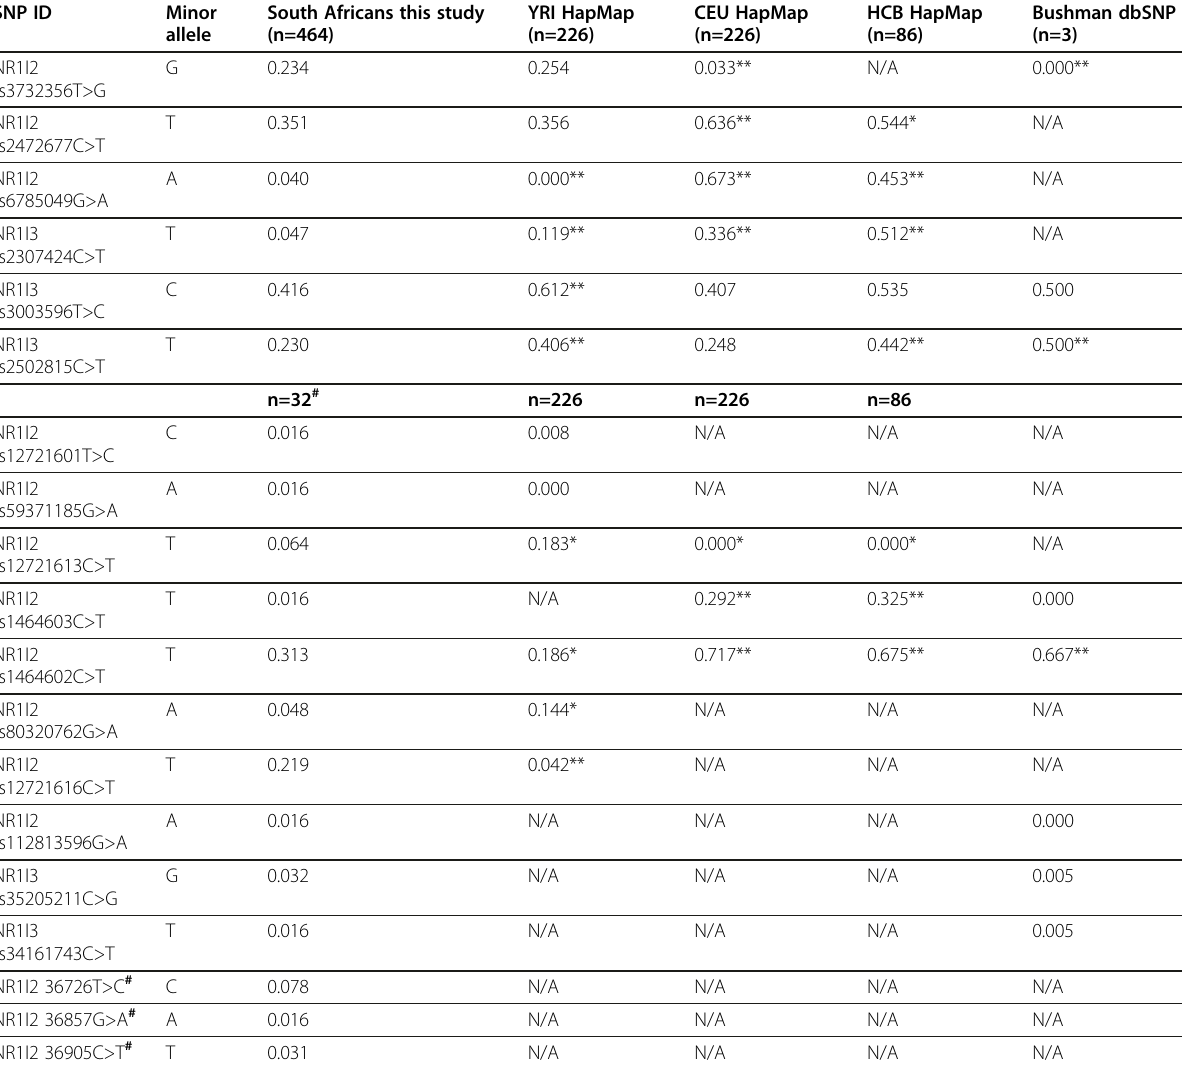
Table 5 Comparison of the allele frequencies between the South Africans and other populations SNP ID Minor South Africans this study allele (n=464)